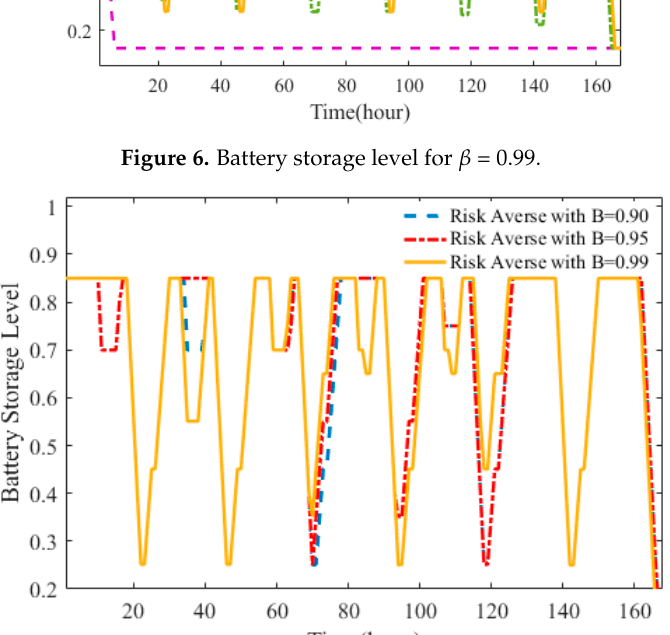
Figure 7. Battery storage level for β = 0.9, β = 0.95, and β = 0.99.